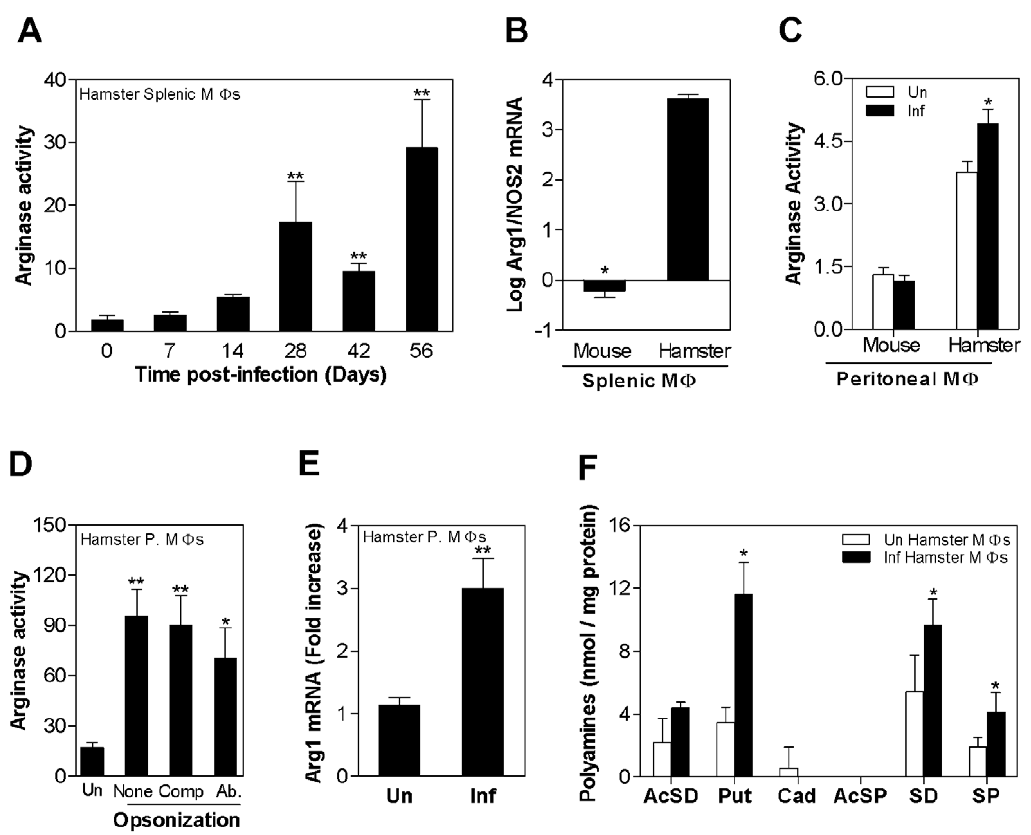
Figure 5. Arg1 expression and polyamine content in L.donovani infected macrophages. A ) Arginase activity in macrophages isolated by adherence from single-cell suspensions from the spleens of control hamsters (0 days post-infection) and hamsters infected with L. donovani for 7, 14, 21, 42, and 56 days. The mean and SD (error bars) of the arginase activity in 100,000 cells, determined by assay of urea production, is shown from a single experiment that is representative of 2 independent experiments. B ) Log 10 ratio of host arg1 to NOS2 mRNA in splenic macrophages of 4-week L. donovani infected mice and hamsters. The mRNA expression was determined by real time RT-PCR in groups of 5 animals and used to calculate the log ratios, shown as the mean and SD (error bars) from a single experiment that is representative of 2 independent experiments. The ratios were determined from the following raw data: Arg1 mRNA fold-increase with reference to the BHK cell calibrator (mean 6 SD): uninfected mice, 5.7 6 5.9; uninfected hamster, 3,367 6 2,858, infected mice, 8.5 6 10; infected hamster, 131,984 6 56,407; iNOS mRNA fold-increase with reference to BHK cell calibrator (mean 6 SD): uninfected mice, 133.34 6 182.4; uninfected hamster, 1.03 6 0.3, infected mice, 2,984 6 4,535; infected hamster, 19.56 6 10.87). C ) Arginase activity in peritoneal macrophages isolated from mice and hamsters that were uninfected (open bars) or infected in vitro with L. donovani for 48 hrs (filled bars). The mean and SD (error bars) of the arginase activity, determined by assay of urea production, is shown from a single experiment that is representative of 2 independent experiments. D ) Arginase activity in hamster peritoneal macrophages that were uninfected (Un) or infected in vitro with L. donovani (1:5 macrophage:parasite ratio). Parasites were either unopsonized (None), opsonized with normal fresh complement-containing hamster serum (Comp), or opsonized with freeze-thawed hamster serum containing anti-Leishmania antibody (Ab). The mean and standard deviation (error bars) of the arginase activity in 200,000 cells of 6 different samples determined by assay of urea production, is shown from a single experiment that is representative of 2 experiments. Statistical comparisons are made to the control group. E ) Expression of hamster arginase mRNA in hamster peritoneal macrophages that were uninfected (Un) or infected in vitro with L. donovani stationary-phase promastigotes for 24 hrs (Inf). The mean and SEM (error bars) of the fold-increase of arg1 mRNA relative to BHK cells, determined by real time RT-PCR in groups of 6 samples per experiment, is shown as data pooled from 4 independent experiments. F ) The concentration of polyamines in uninfected (open bars) and 48-hour in vitro infected hamster peritoneal macrophages (filled bars) (n=6 per group) is expressed as the mean and SD (error bars) of nmol polyamine per mg protein. The data shown are from a single experiment that is representative of 2 independent experiments. The statistical significance of differences in each of the panels is identified by asterisks (*, p , 0.05; **, p , 0.01; ***, p ,